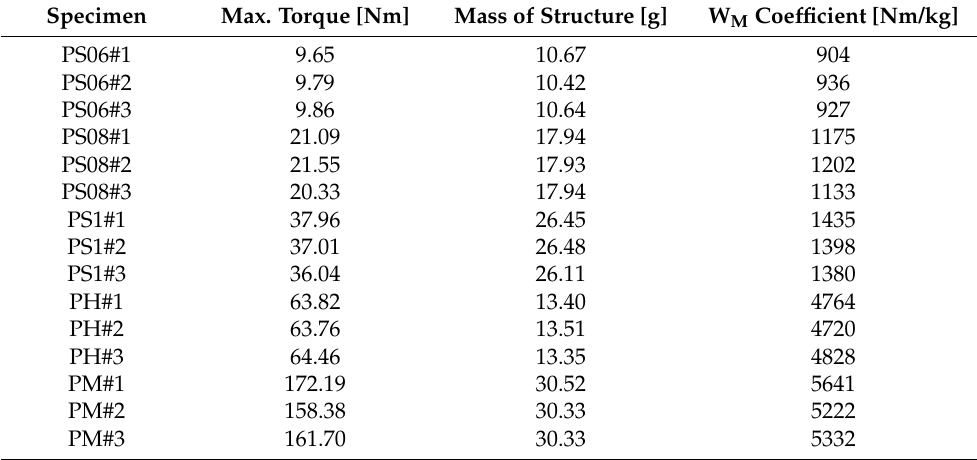
Table 4. Registered results for different cell